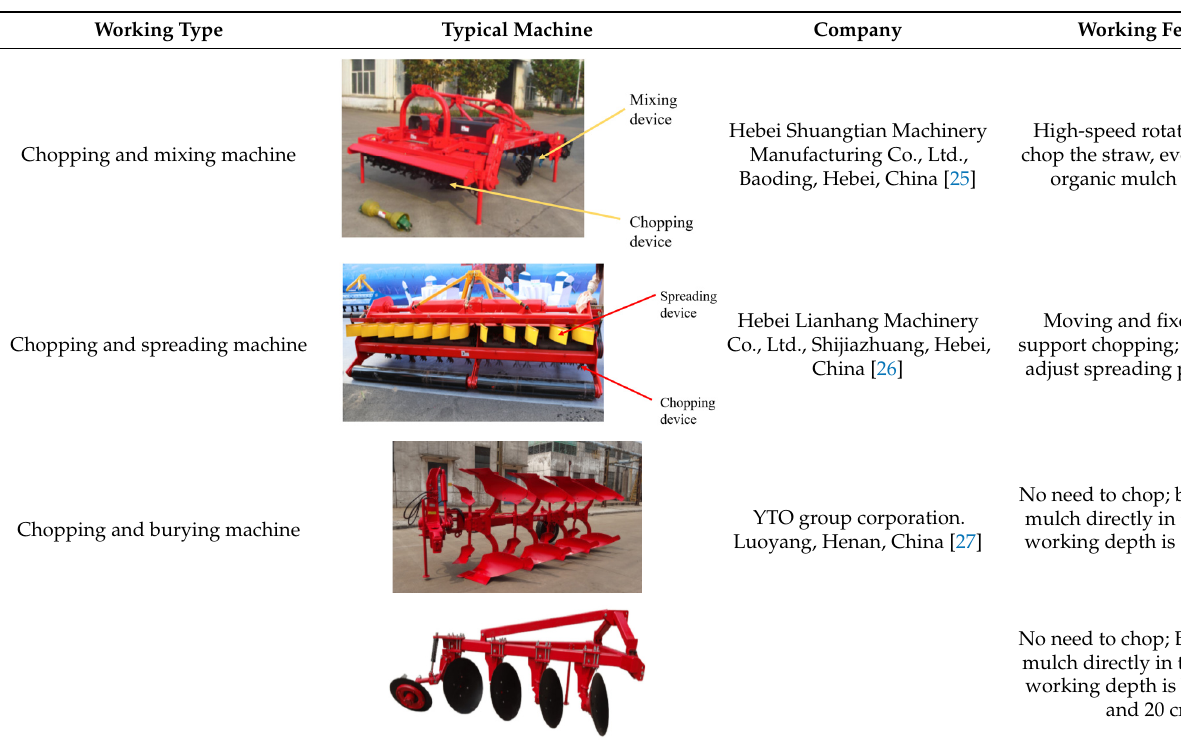
Table 3. Typical machines of soil organic cover in China.